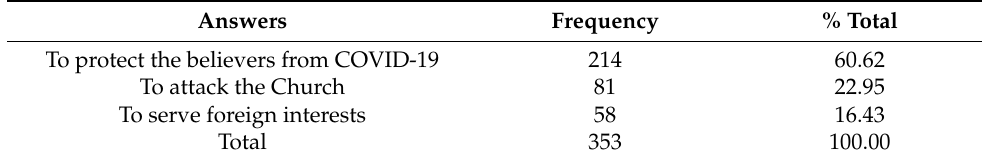
Table 4. Results for the attitudes of believers for the closing of Churches.